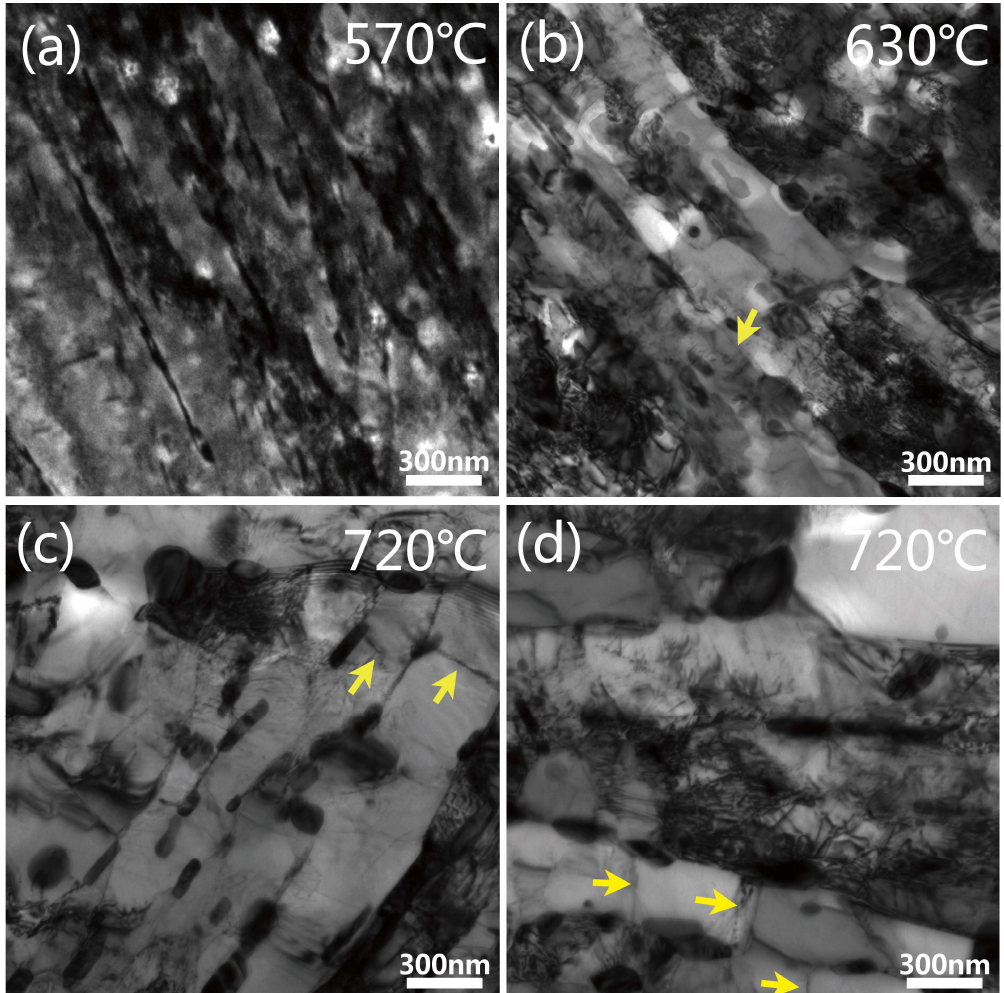
Figure 2. TEM images showing the recovery of martensite lath in 42CrMo4-V steel tempered at: ( a ) 570 °C; ( b ) 630 °C; ( c ) 720 °C; ( d ) 720 °C. ( a ) 570 ◦ C; ( b ) 630 ◦ C; ( c ) 720 ◦ C; ( d ) 720 ◦